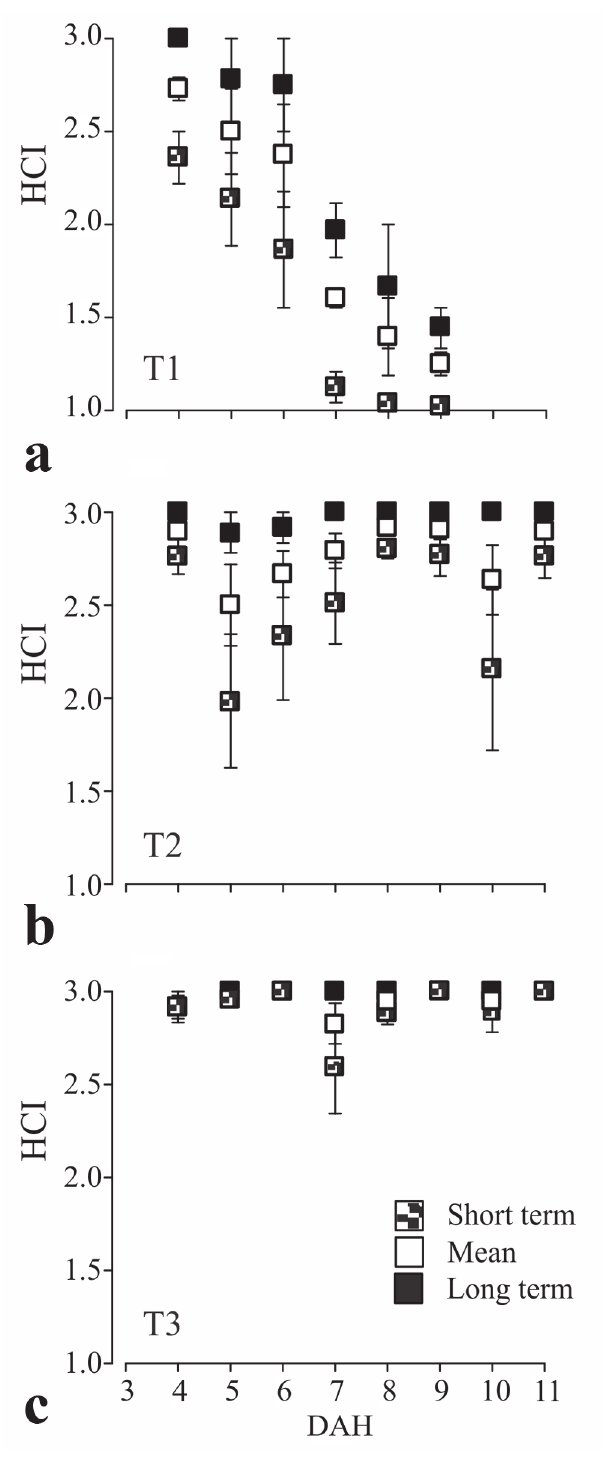
Fig. 7. Mean histological condition index (HCI) and standard error for Pagrus pagrus larvae calculated employing short or long term tissues and a mean value employing all tissues against larval age expressed as days after hatching (DAH) from the feeding treatments, a: without food (T1); b: delayed feeding (T2); c: fed